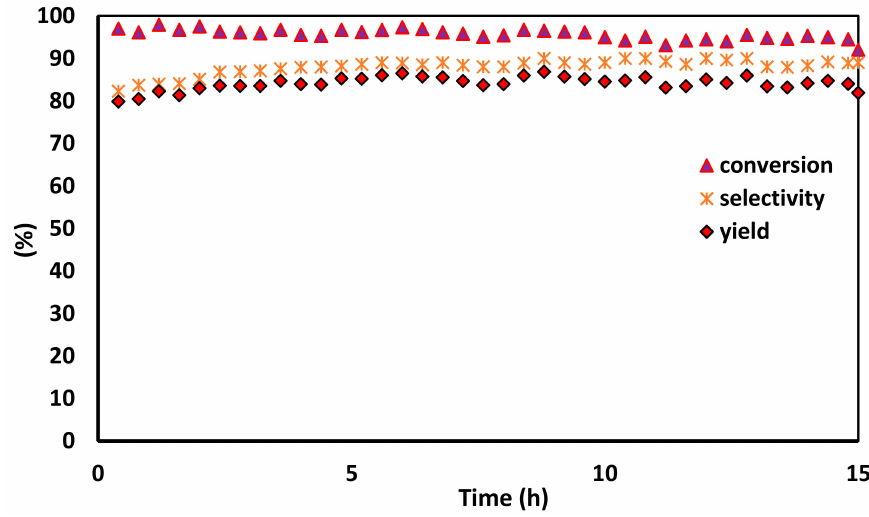
Figure 12. The conversion, selectivity and yield of 0.08%Pd0.29%Ir/H-Beta(i) as a function of time on stream at 55 ◦ C, GHSV = 4030 h − 1 , R = 3 and p = 20